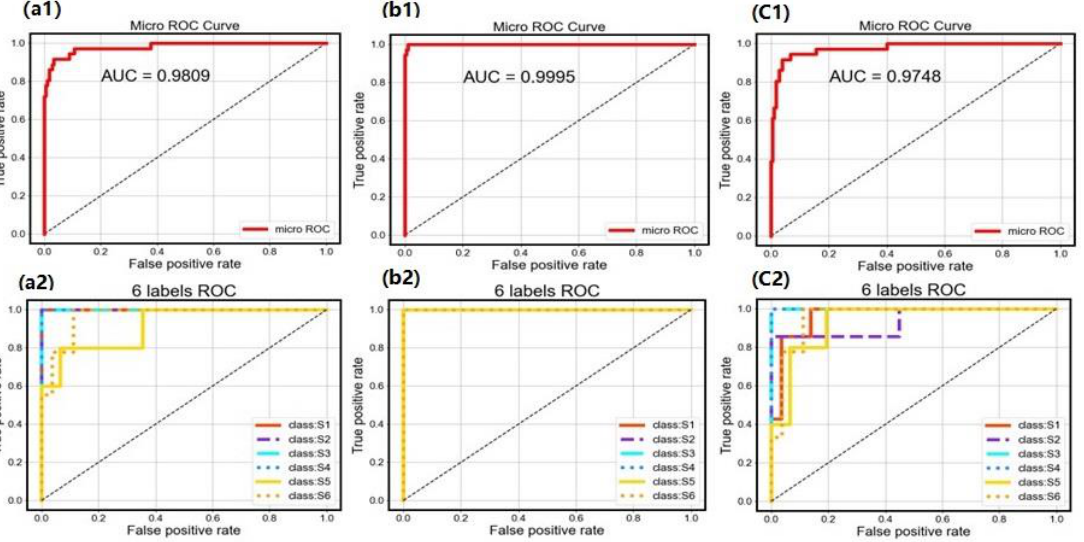
Figure 8. Evaluation of GBDT classification based on different datasets: ( a1 ) AUC based on the orig- inal data, ( b1 ) AUC based on the PCA data, and ( c1 ) AUC based on the TNSE data; ( a2 ) ROC curve based on the original data, ( b2 ) ROC curve based on the PCA data, and ( c2 ) ROC curve based on the TNSE data. Class S1 refers to LRW, class S2 refers to LE, class S3 refers to ICRE, class S4 refers to AeroE, class S5 refers to ANE, and class S6 refers to MBRE.